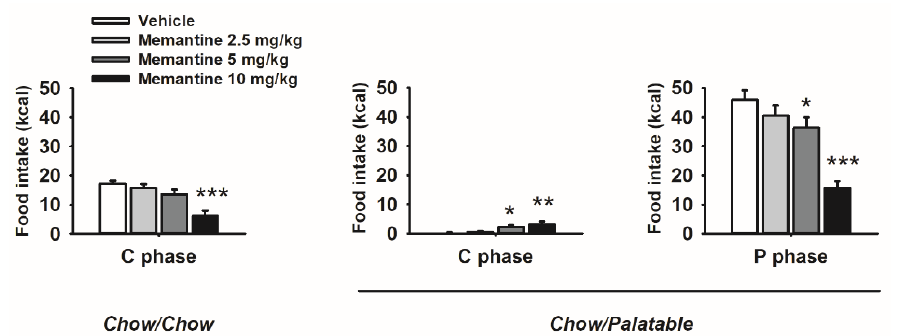
Figure 5. Effects of systemic administration of memantine (0–10 mg/kg) on food intake in Chow/Chow Figure 5. E ff ects of systemic administration of memantine (0–10 mg / kg) on food intake in Chow / Chow and Chow/Palatable male Wistar rats undergoing the ad libitum diet alternation. ( n = 10/group) Data and Chow / Palatable male Wistar rats undergoing the ad libitum diet alternation. ( n = 10 / group) Data show M ±SEM. * p ≤ 0.05, ** p ≤ 0.01, *** p ≤ 0.001 vs. vehicle. show M ± SEM. * p ≤ 0.05, ** p ≤ 0.01, *** p ≤ 0.001 vs.